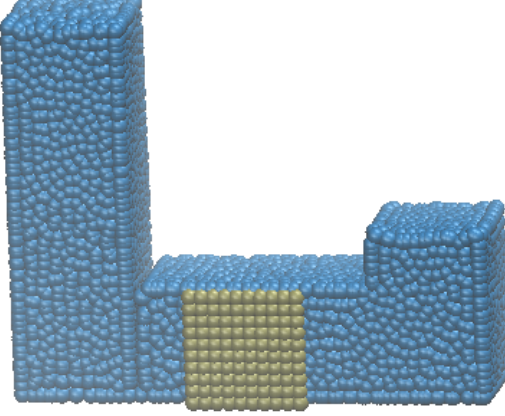
Figure 5. SPH liquid flow through porous